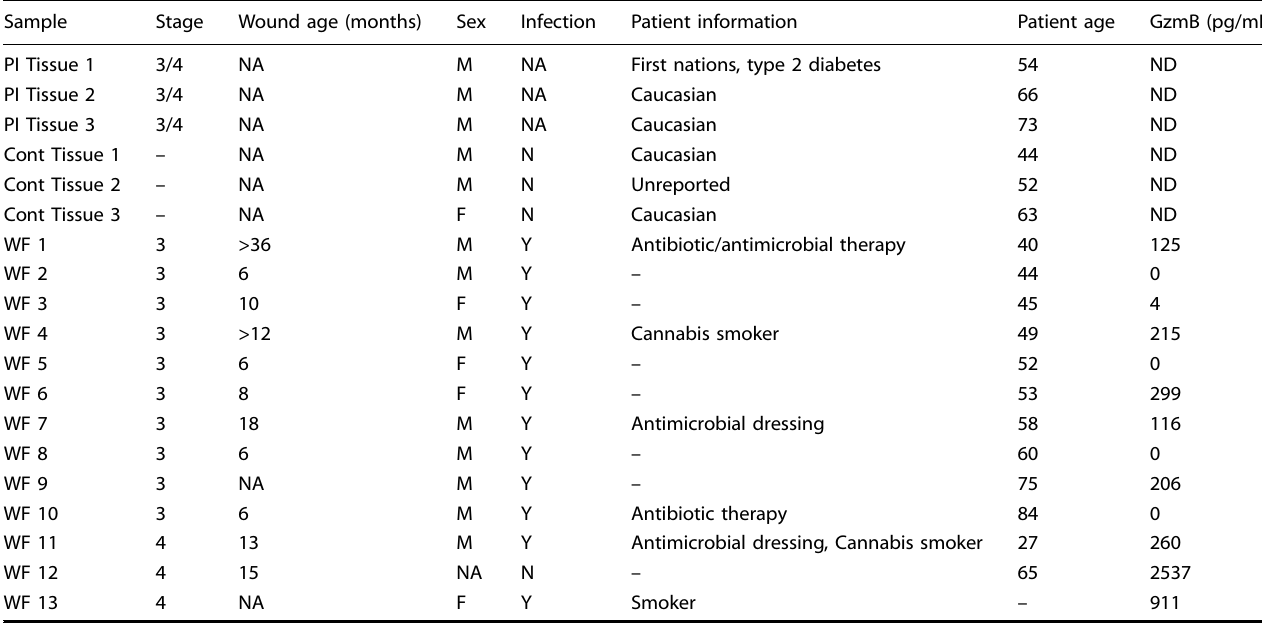
Table 1. PI patient